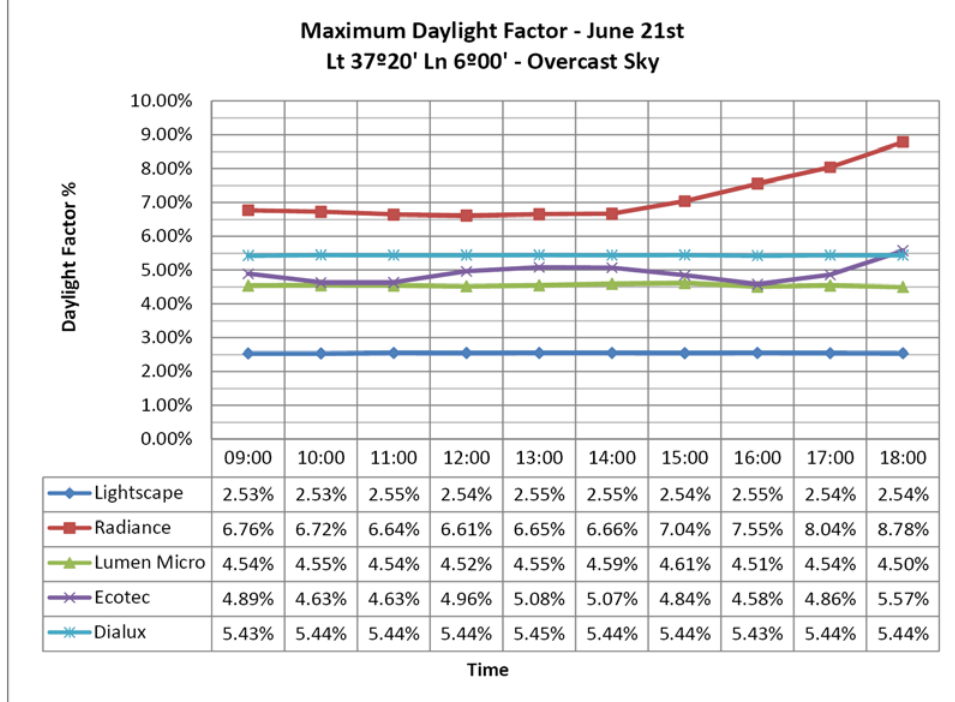
Figure 5. Maximum Daylight Factor Levels. From 9:00 until 18:00 on June 21st, overcast